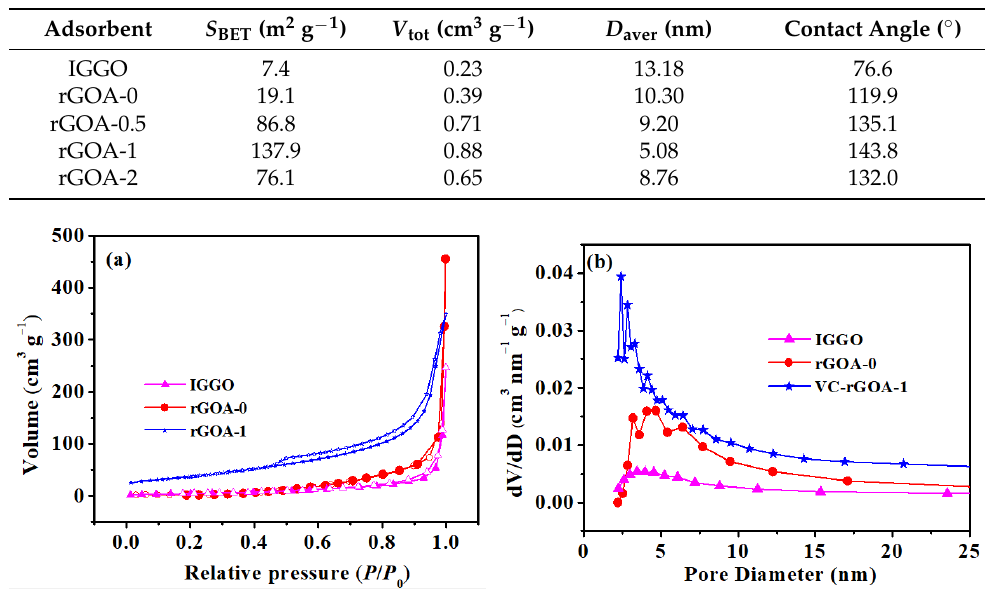
Figure 1. The nitrogen adsorption–desorption isotherms ( a ) and pore size distribution ( b ) by IGGO, rGOA-0, and rGOA-1. rGOA-0, and